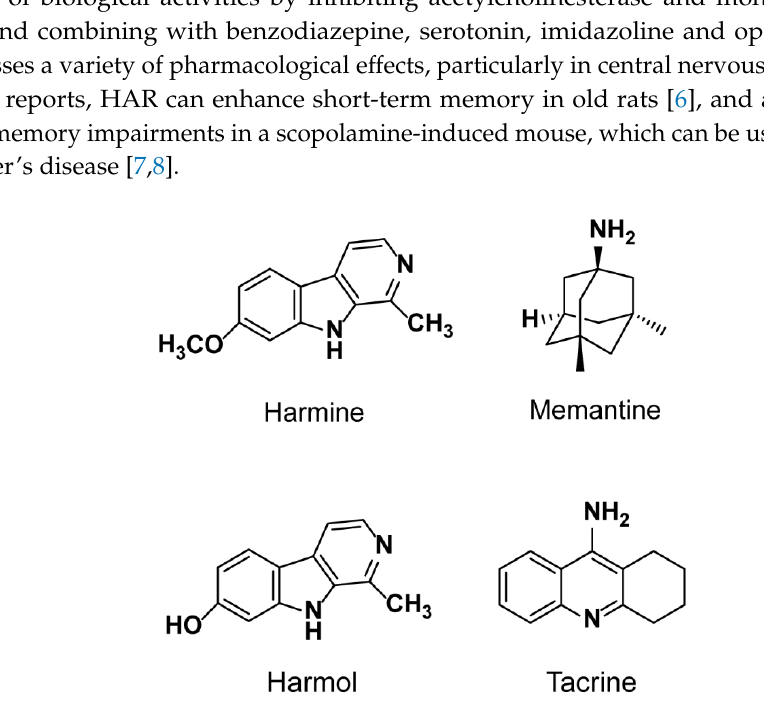
Figure 1. Chemical structures of harmine (HAR), memantine (MEM), harmol (HOL) and tacrine (IS).